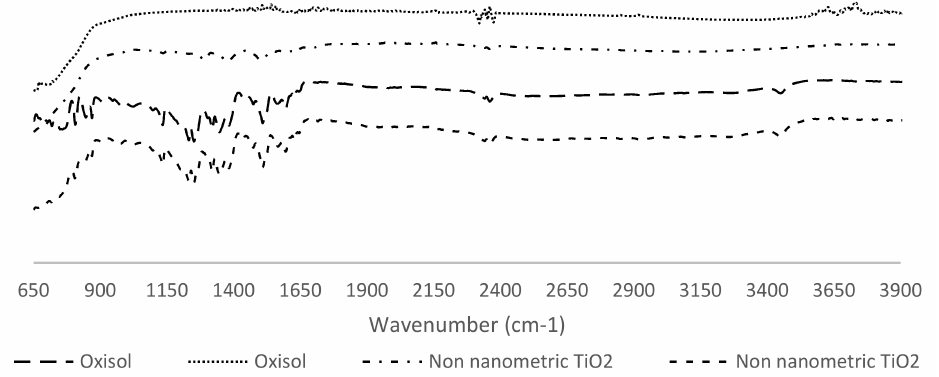
Figure 4. Comparison between FT-IR spectra of TiO 2 , TiO 2 / Oxisol mixture, functionalized TiO 2 , and